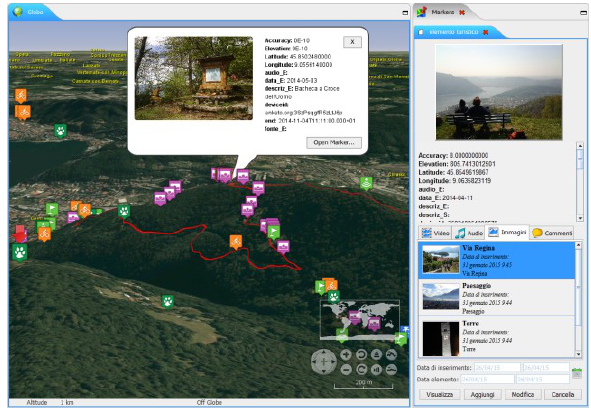
Figure 5. Visualization of the detailed data for the selected